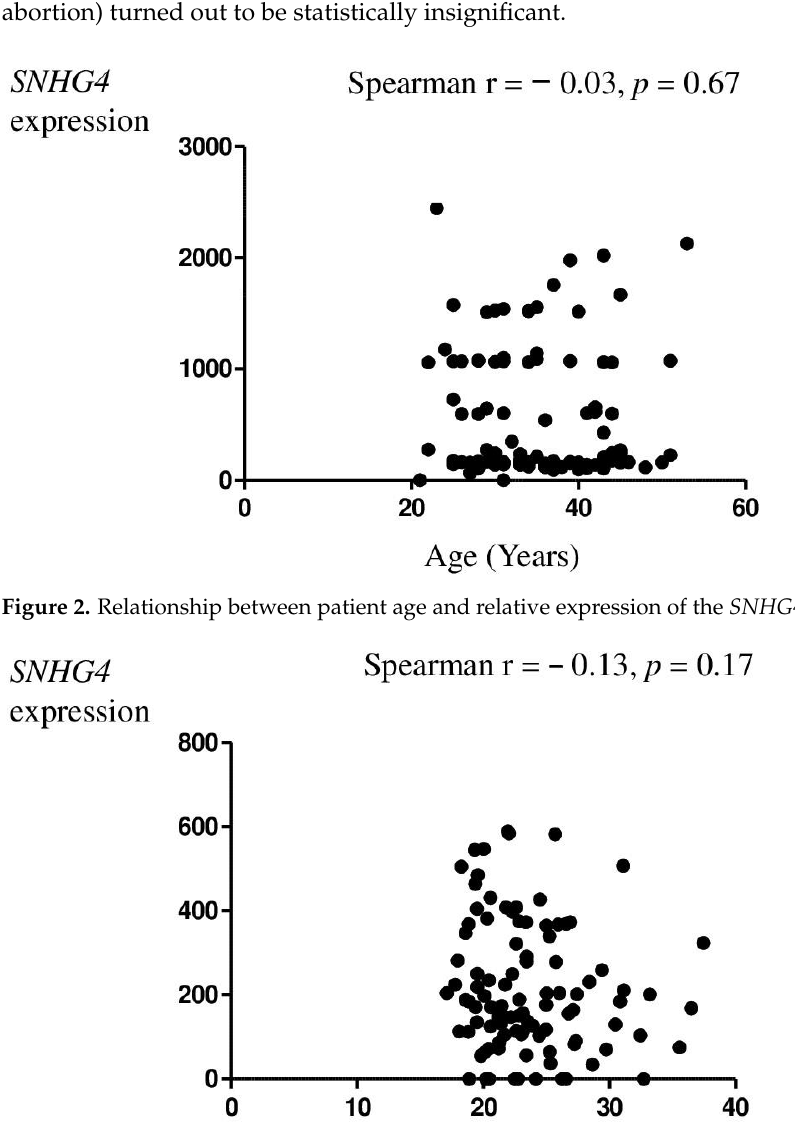
Figure 3. Correlation between patient BMI and relative expression of the SNHG4 gene.